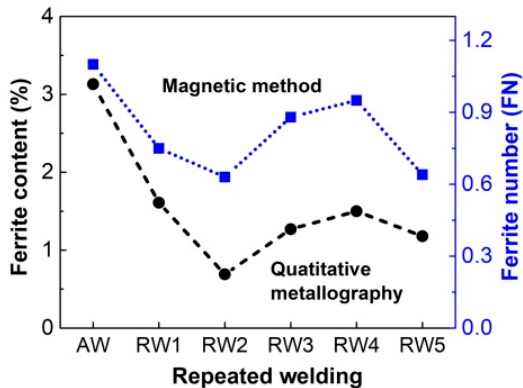
Figure 12. δ -ferrite contents measured in AISI 304N austenitic stainless steel of the as-welded and repeated welding by the quantitative metallography method and magnetic method for the AW and RW1–RW5 specimens.